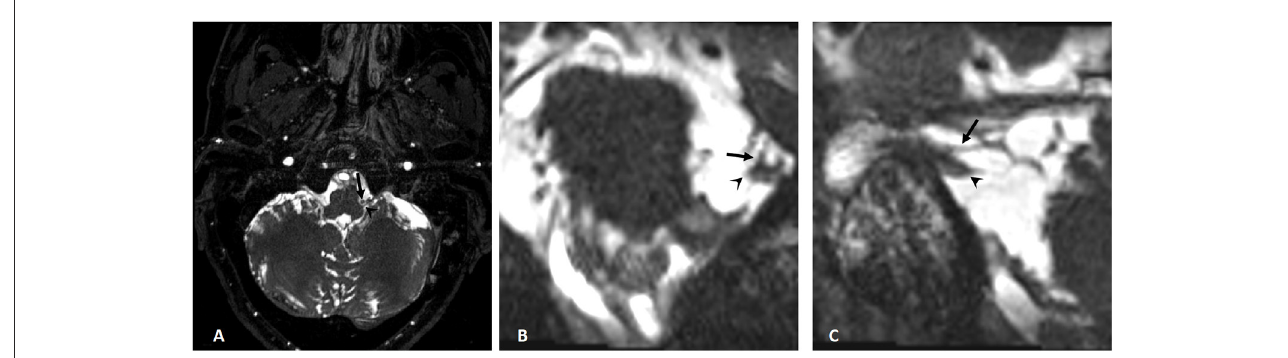
FIGURE2 MRI before the second operation. (A) The structure around the left glossopharyngeal nerve is disordered, and the original posterior inferior cerebellar artery (arrow) seems to be moved with no compression to the left glossopharyngeal nerve (arrowhead); (B, C) The left trigeminal nerve (arrowhead) touches the superior cerebellar artery (arrow).